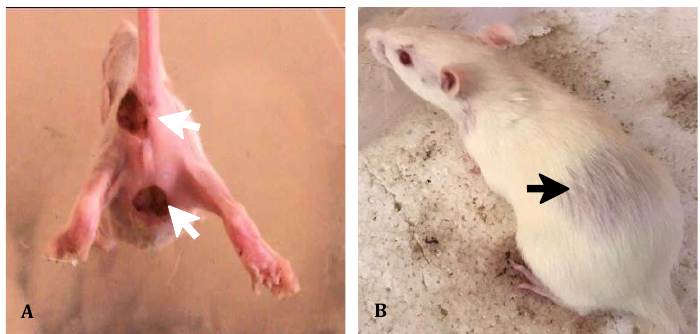
Figure 4. Photographs of rat pupies from carvedilol-methotrexate combination group, showing skin ulceration ( A ), alopecia ( B